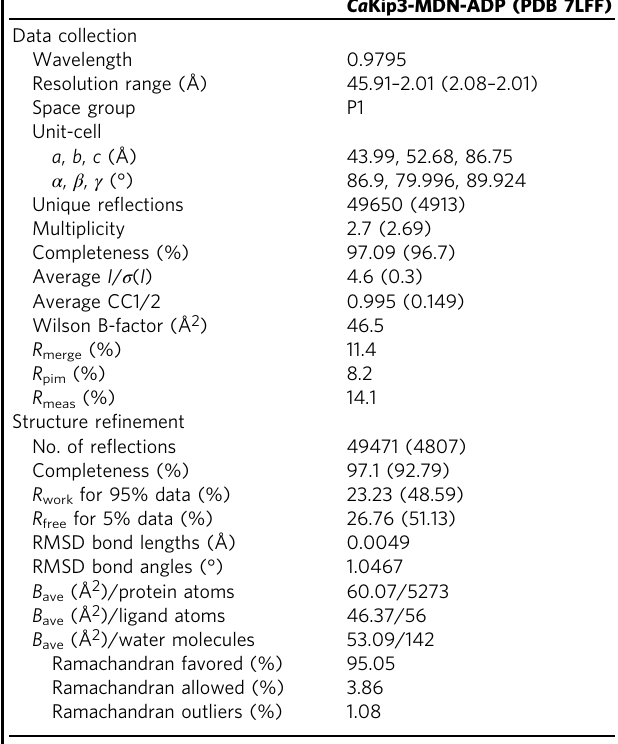
Table 1 X-ray diffraction data collection, re fi nement, and validation